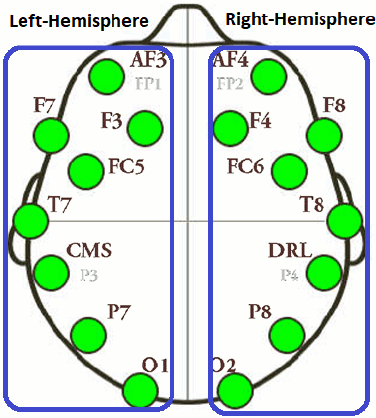
Figure 5. Electrodes layout of LH and RH.